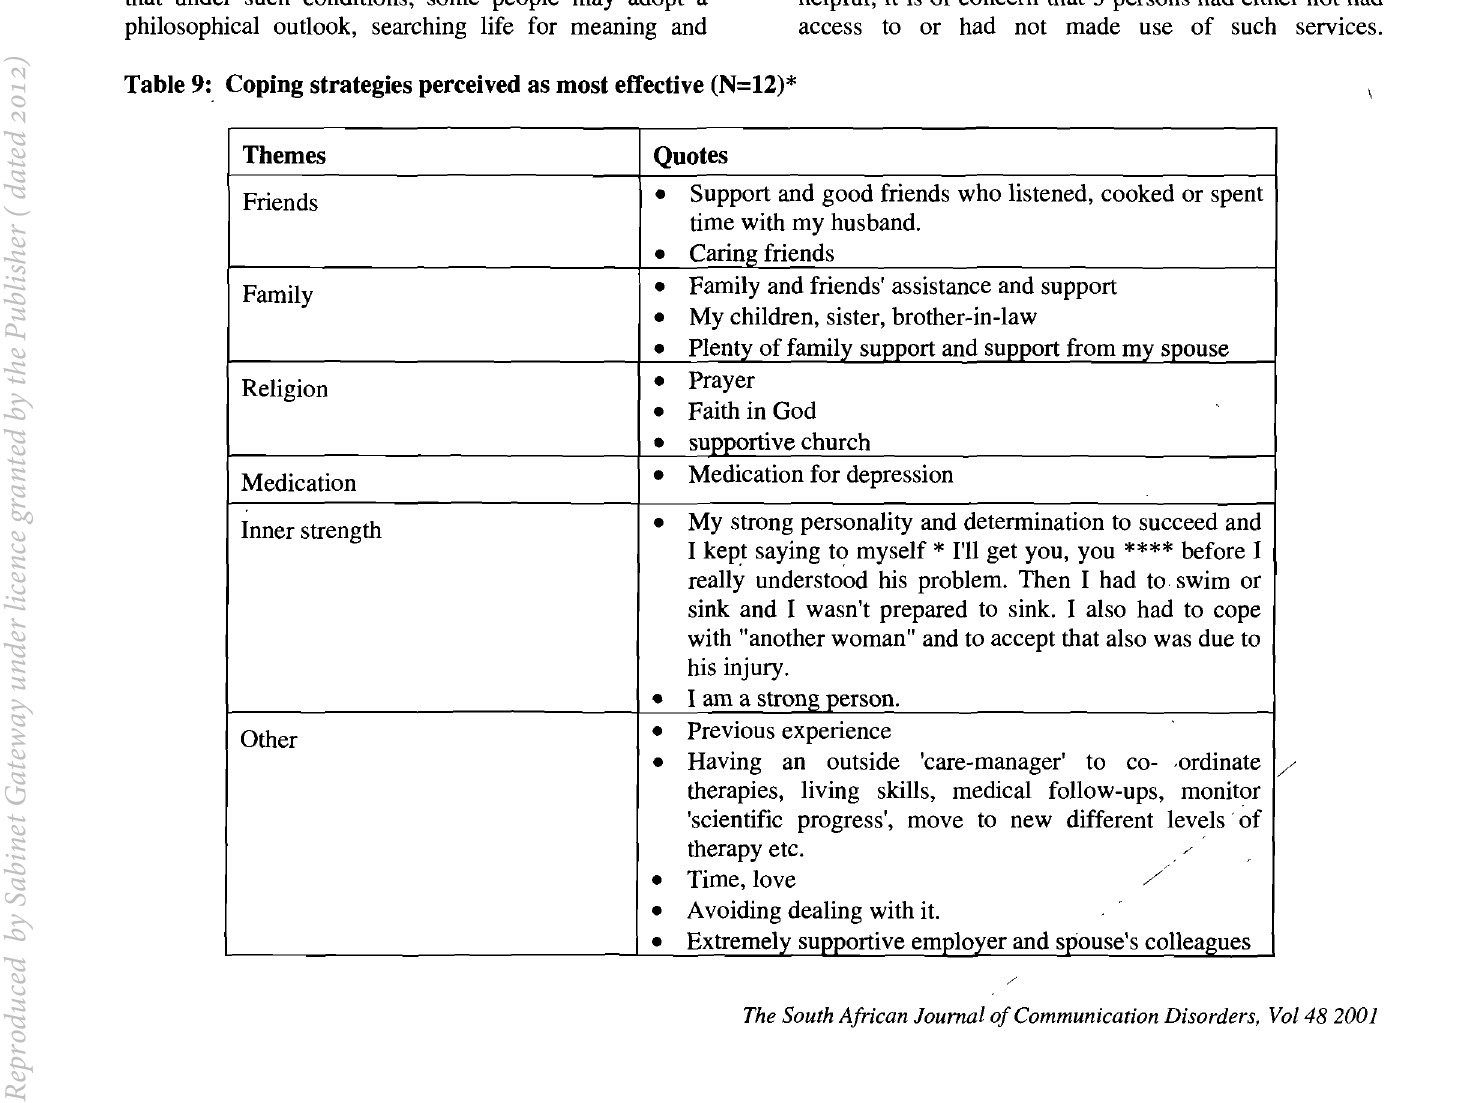
Table 8: Extent of helpfulness of coping resources (N=14)